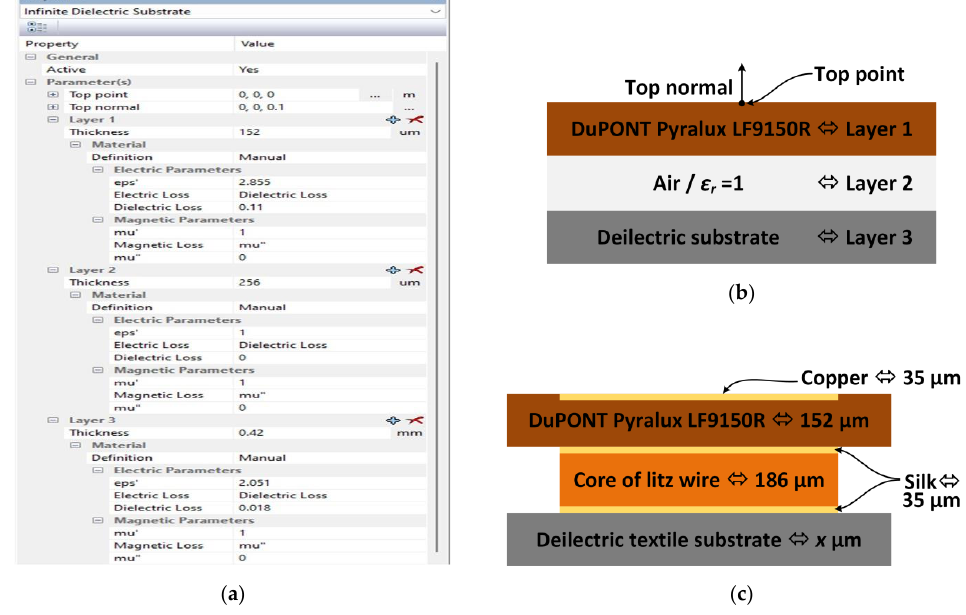
Figure 15. Model of RFIDtex transponder in EMCoS Studio: ( a ) definition of infinitive dielectric substrates; ( b ) model of dielectric substrates; ( c ) model completed with conductive components.